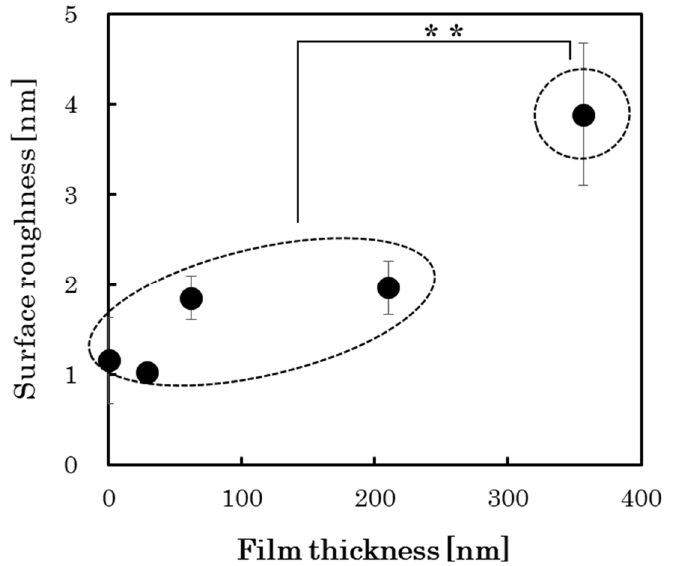
Figure 8. Surface roughness of the PLC films with different thicknesses. ** p < 0.01